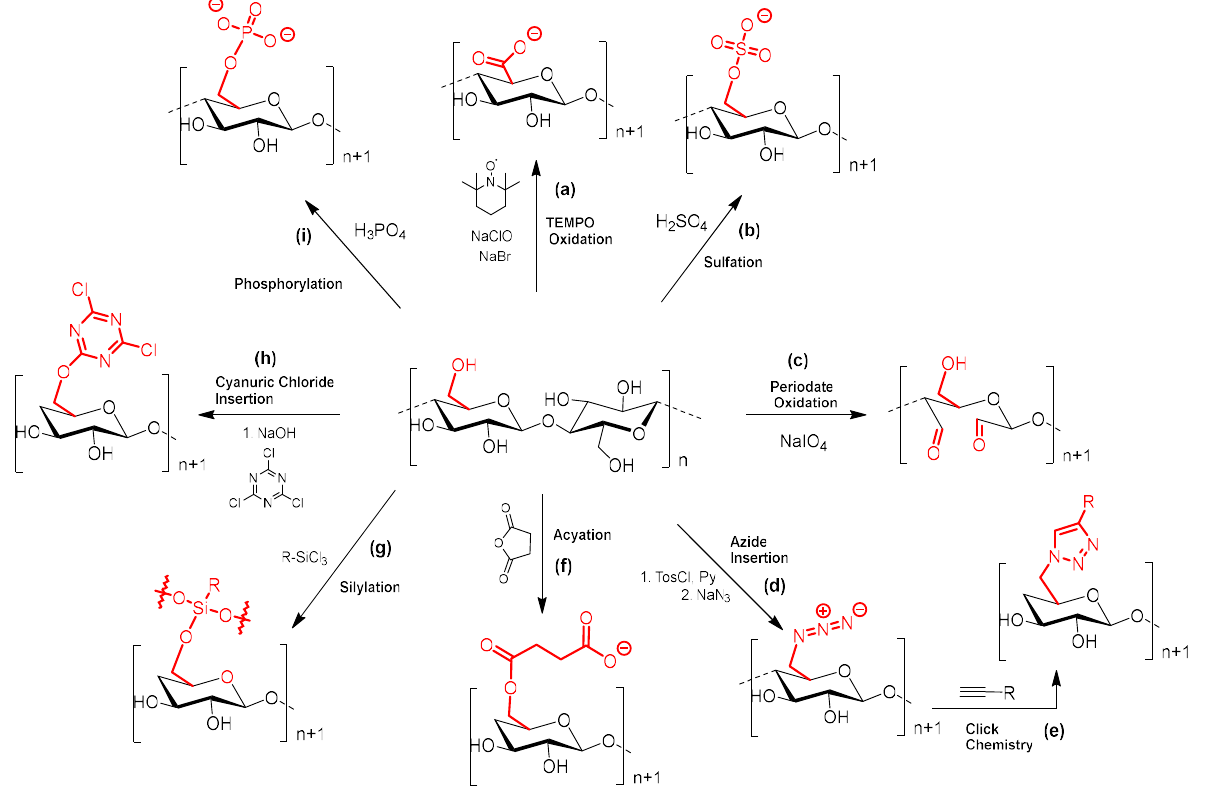
Figure 3. Common chemical modifications of cellulose discussed in the current